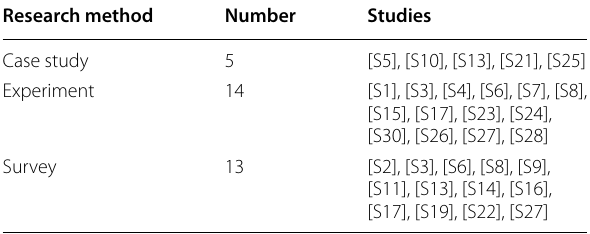
Table 11 Research methods